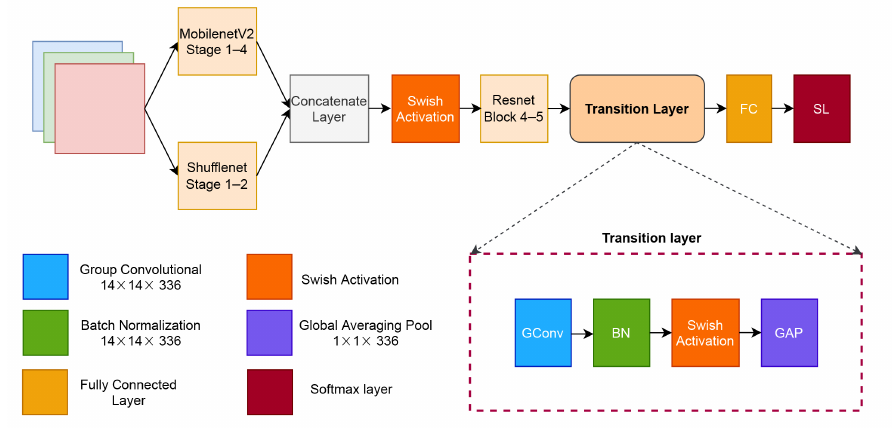
Figure 2. Architecture of the proposed model.